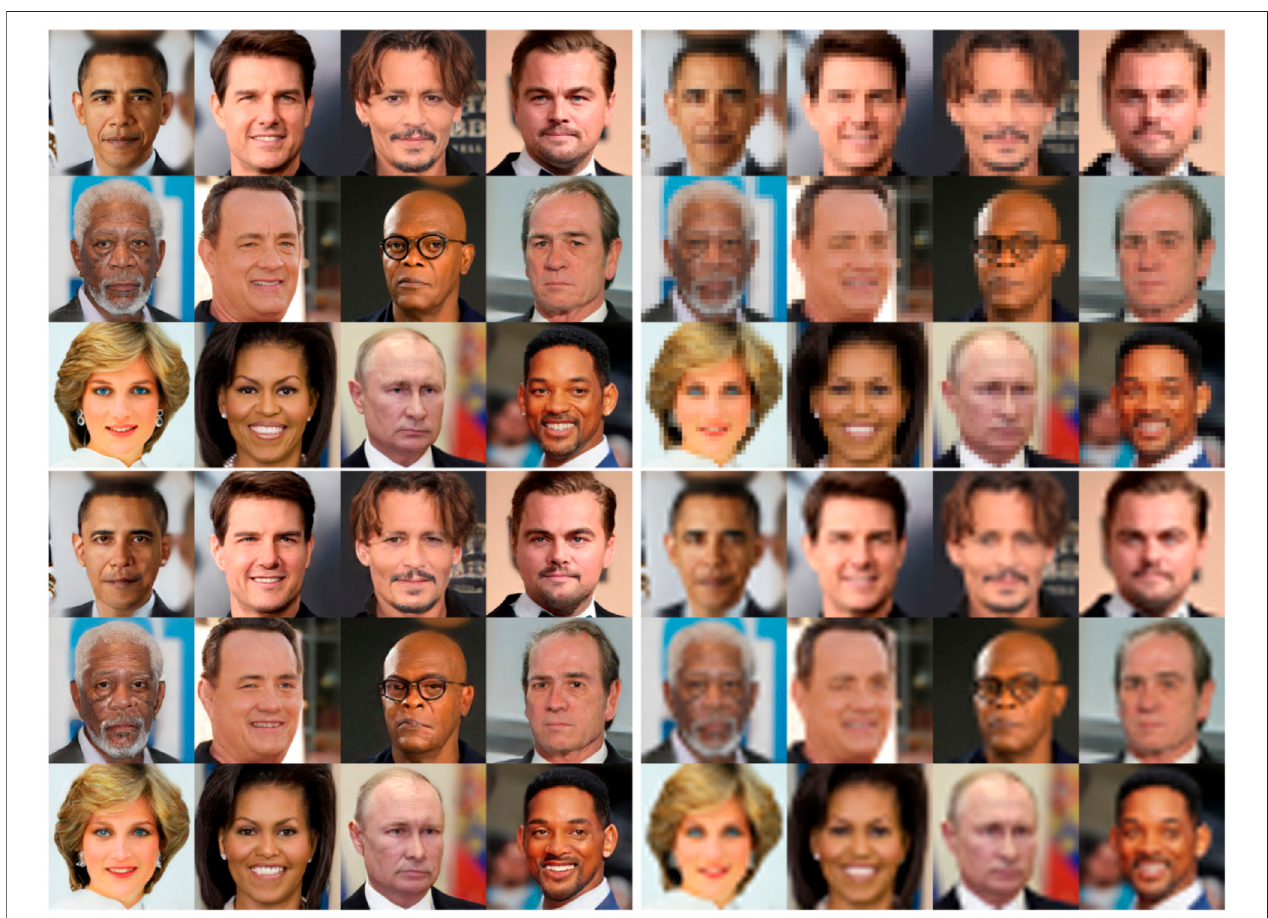
FIGURE 2 | The top-left picture shows some HR faces of celebrities in C 32 , the top-right picture shows the generated LR version (32 × 32), the bottom-left picture shows the super-resolution version obtained with the GLEAN algorithm, and the bottom-right picture shows the interpolated version. The web address of pages containing celebrities faces is provided in the Supplementary Material . Sources include biography.com , Wikipedia , mubi.com , imbd.com , theguardian.com , nientepopcorn.it ilsussidiario.net , notizie.it .